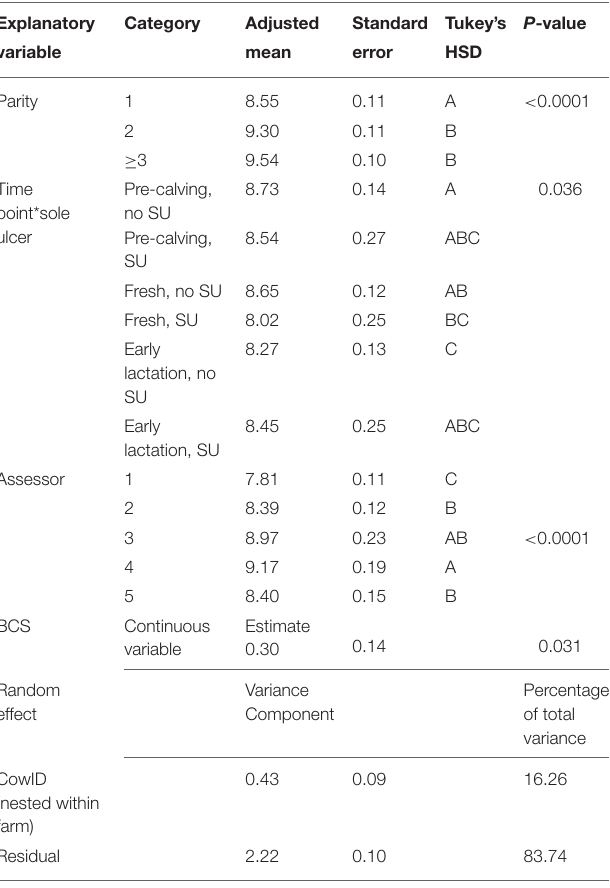
TABLE 3 | Results from multivariable logistic regression models for outcomes SU, SH, and WLD.